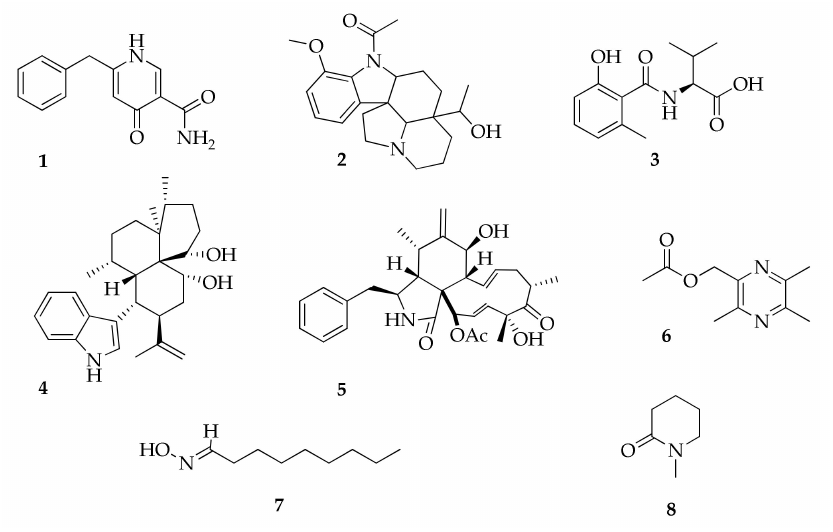
Figure 2. Structures of alkaloids.